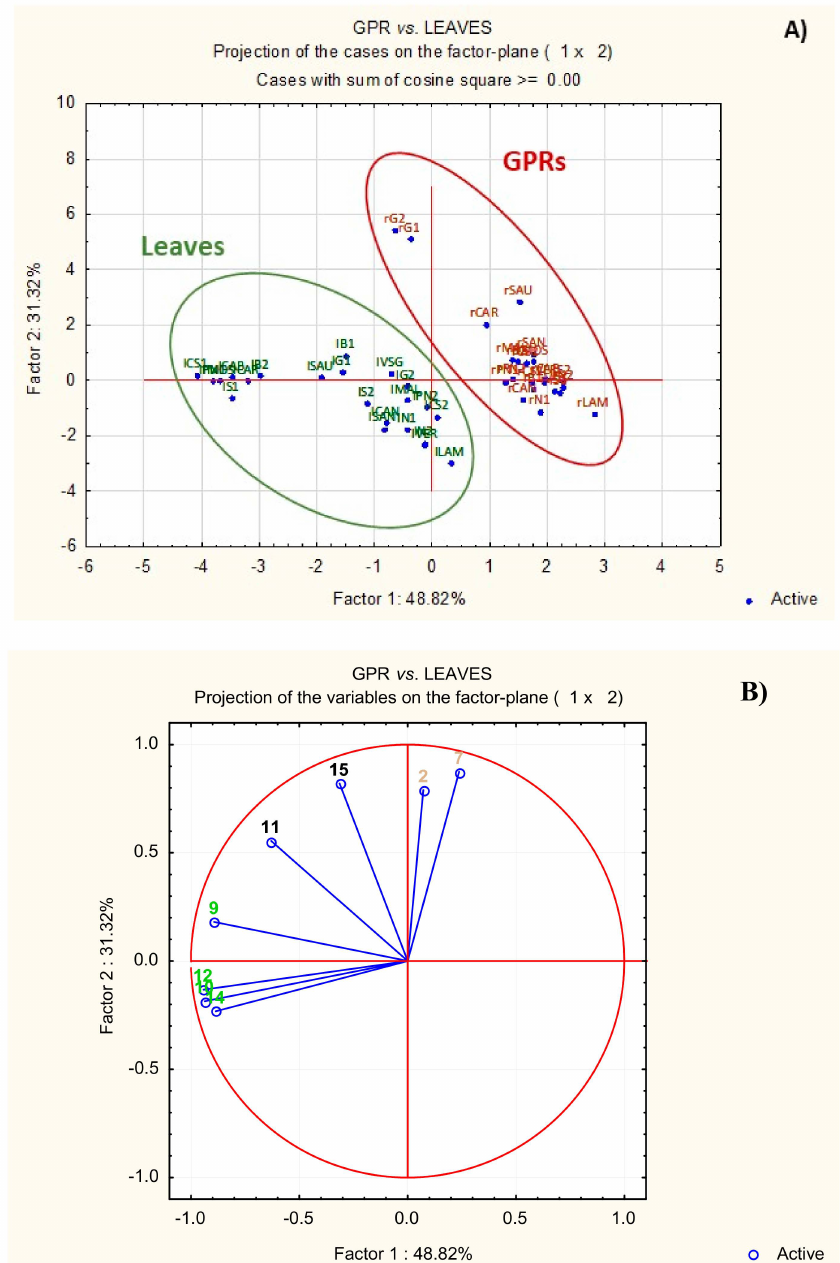
Figure 3. Score plot ( A ) and loading plot ( B ) of the principal component analysis relative to the quantity of the main phenolic compounds in green pruning residues (GPRs) (r) and leaves (l). In the score plot, GPRs are in brown and leaves in green. In the loading plot: (2), caftaric acid; (7), myricetin glucuronide; (9), rutin and hyperoside; (10), quercetin 3- O -glucoside; (11), quercetin 3- O -glucuronide; (12), kaempferol-3- O -rutinoside; (14), kaempferol-3- O -glucoside and quercetin malonylhexoside; and (15), isorhamnetin glucuronide. The analytes significantly more abundant in GPRs are in brown and those significantly more abundant in leaves are in